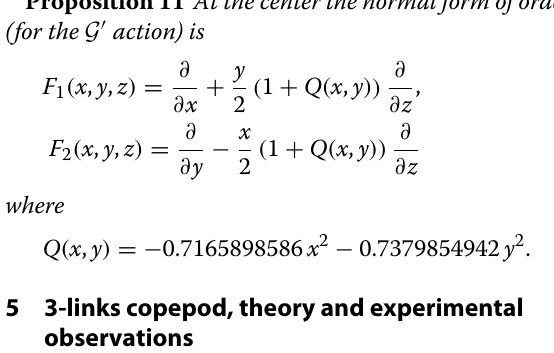
be identified to the z-variable since for the Heisenberg- Brockett-Dido model we have that ˙ z > 0 and hence z is always increasing, contrary to the copepod swimmer where one stroke produces always forward and backward displacement.